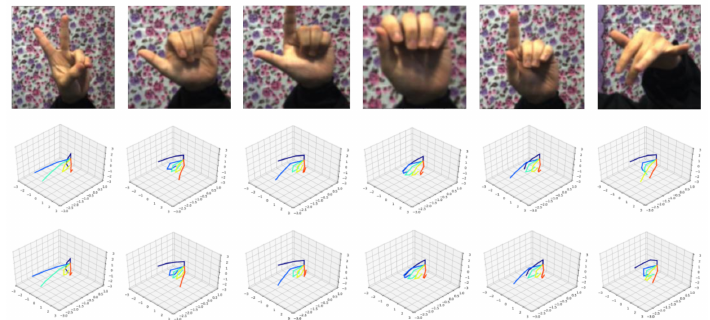
Figure 10. Qualitative results for STB dataset [33].